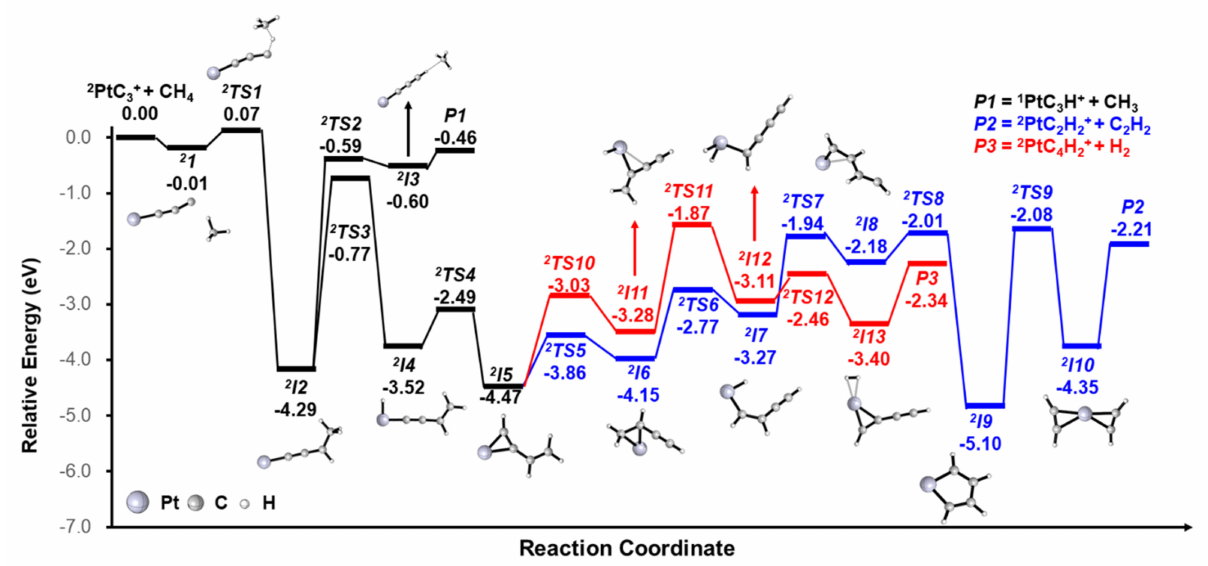
Figure 3. Reaction pathways for generating PtC 2 H 2+ /C 2 H 2 (blue trace), PtC 4 H 2+ /H 2 (red trace) and PtC 3 H + /CH 3 from the reaction of PtC 3+ and CH 4 , calculated at the BMK level. The zero-point vibrational energy-corrected energies (in eV) relative to the entrance channel are